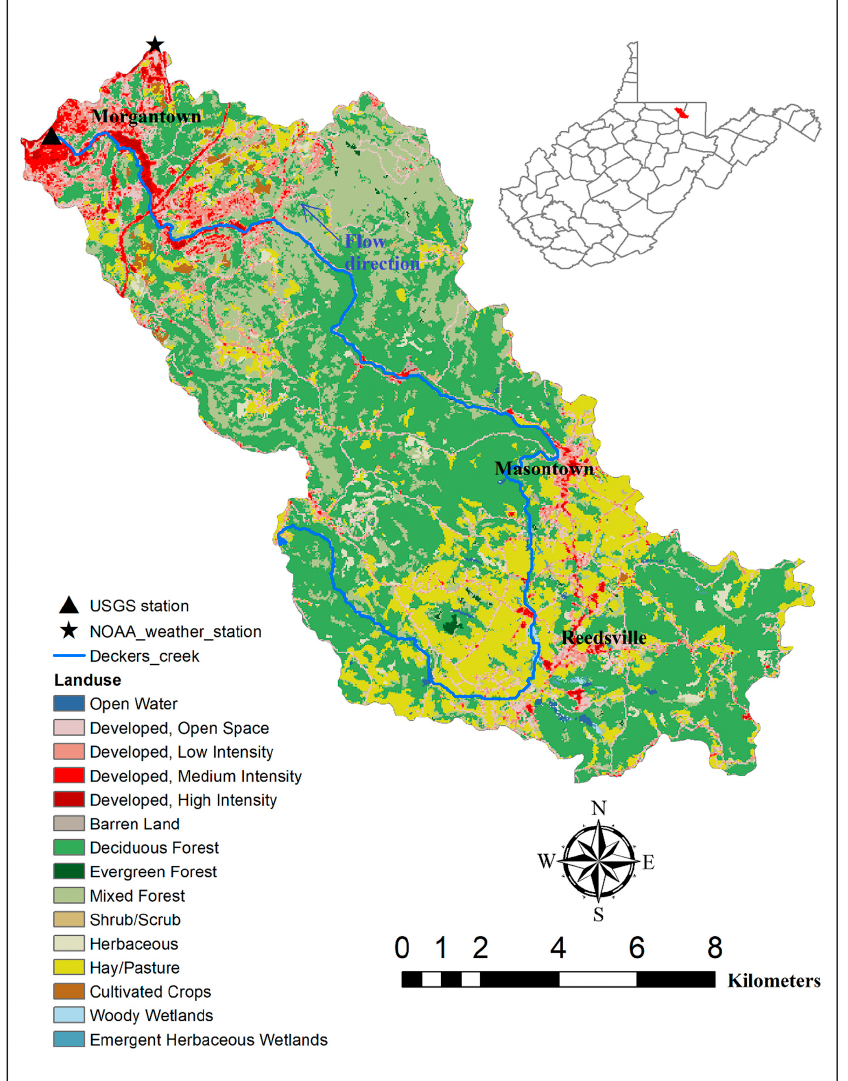
Figure 1. Deckers Creek Watershed (DCW) located in northern West Virginia with USGS station (USGS 03062500) and NOAA weather station (USW00013736).